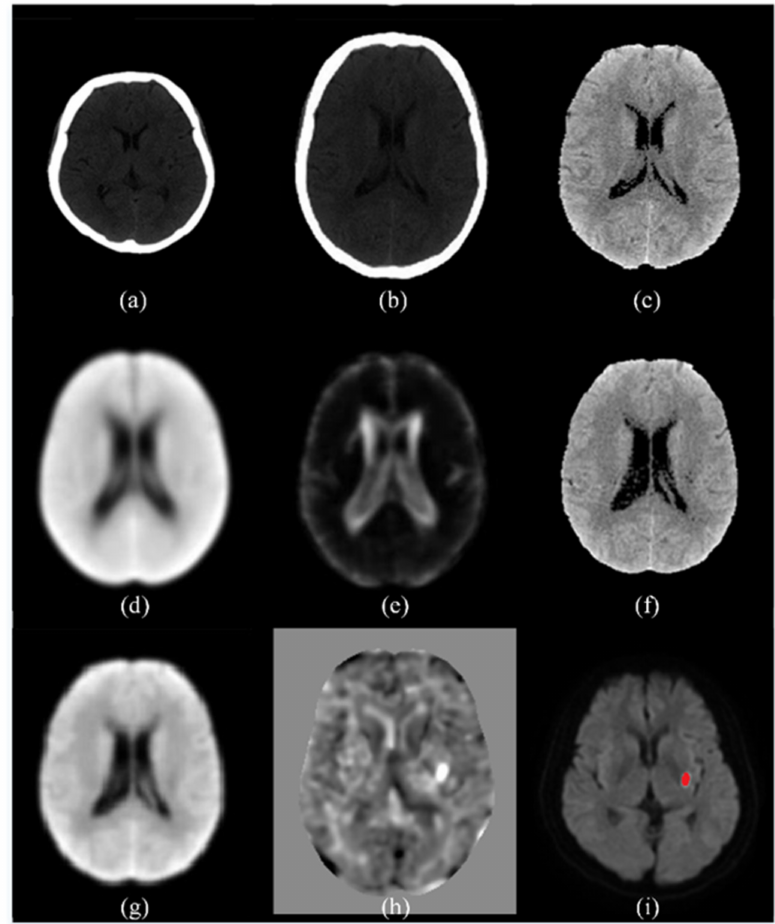
Figure 3. An illustration of the intermediate images in the image preprocessing steps. ( a ) An original control CT image; ( b ) the result of the spatial normalization; ( c ) the result of intensity transformation; ( d ) the average CT map of all control CT; ( e ) the standard deviation CT map of all control CT; ( f ) a patient CT image after normalization to our own CT template; ( g ) the result of spatial smoothing by the kernel with a 5-mm FWHM; ( h ) the t-score map; ( i ) the ischemic infarct area drawn by the experienced